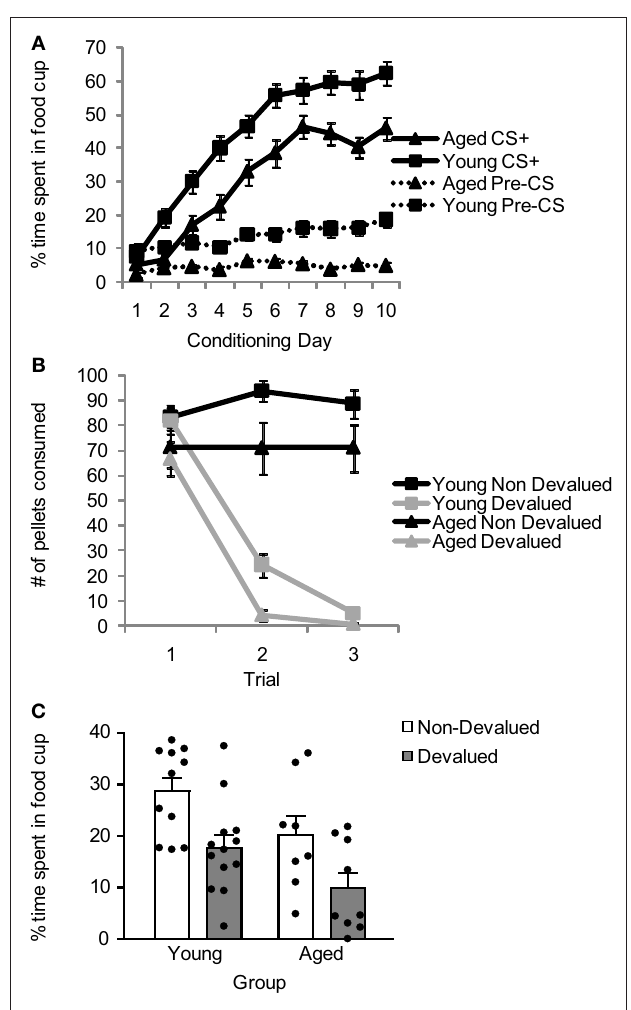
FiGuRe 1 | Comparison of performance of young and aged rats across Pavlovian conditioning (A), reinforcer devaluation (B), and conditioned responding after devaluation (C). Data presented are the mean